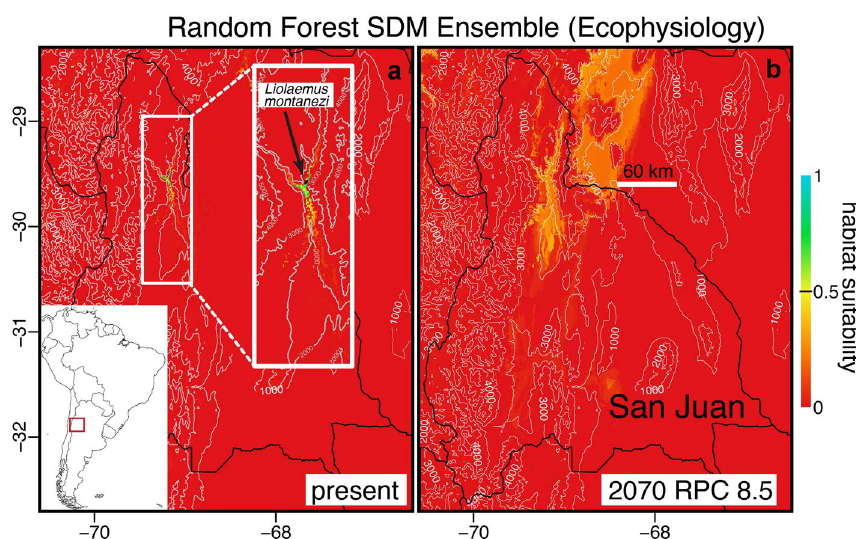
Figure 6. Suitable habitat projections for L. montanezi under ecophysiological layers and random forest algorithm (RF) at present (panel a) and 2070 RCP 8.5 (panel b). The inlay (white square) represents a close-up of the known distribution of the species. Elevation curves are also shown. These maps were generated in the R environment (R Core Team 109 ver. 3.6.1, URL: http:// www.r- proje ct. org/ index. html) using the R-packages: biomod2 ver. 3.4.6 (Thuiller et al. 110 , URL: https:// CRAN.R- proje ct. org/ packa ge= biomo d2), dismo v1.1-4 (Hijmans et al. 111 , URL: https:// CRAN.R- proje ct. org/ packa ge= dismo), and raster v3.3-13 (Hijmans 112 , URL: https:// CRAN.R- proje ct. org/ packa ge= raster) by J.C.